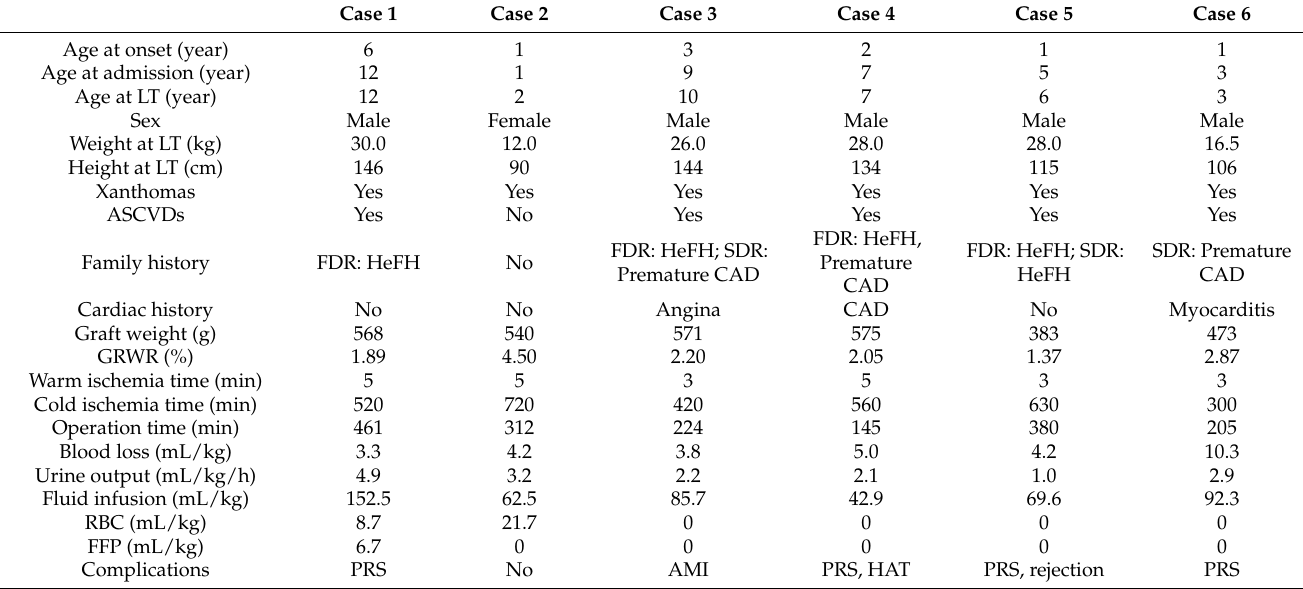
Table 1. Baseline characteristics, intraoperative parameters, and related complications.